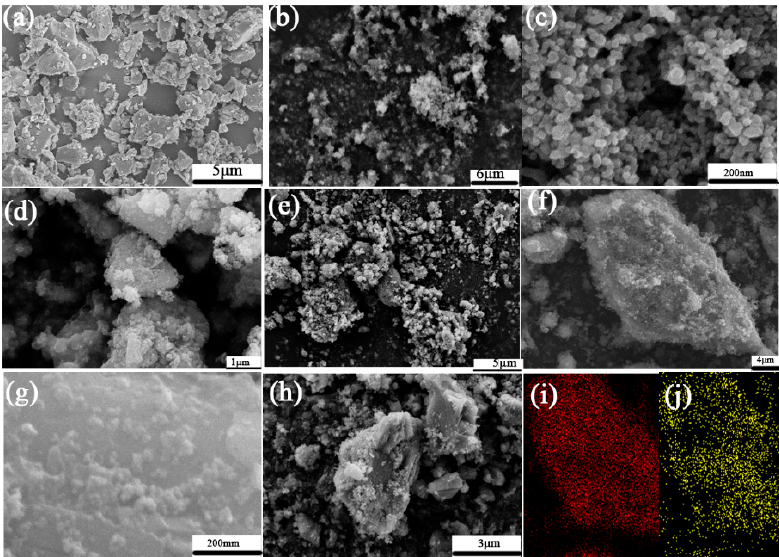
Figure 6. SEM images of CaCO 3 ( a ), TiO 2 ( b , c ), CaCO 3 –TiO 2 composite photocatalyst with TiO 2 mass ratios of 20% ( d ), 40% ( e ), 50% ( f , g ). The mixture of CaCO 3 and TiO 2 ( h ). The mapping of Ca ( i ) and Ti ( j ) corresponding to ( f ).